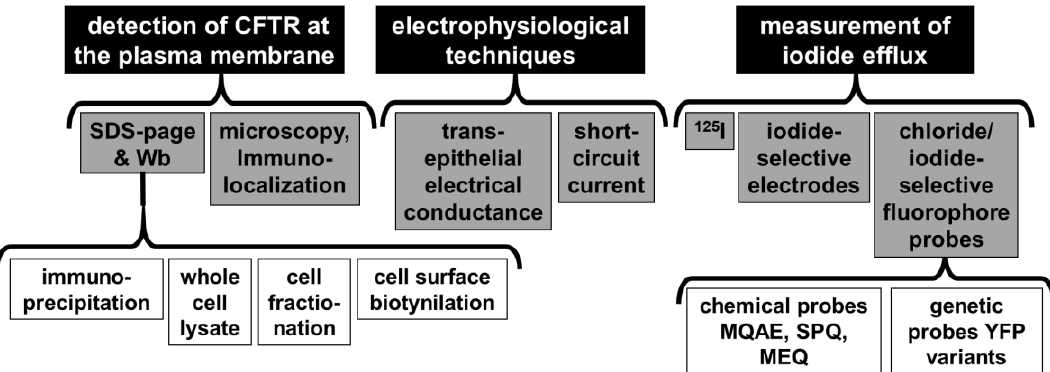
Figure 7 . CFTR functional assays. The main cell-based assays to measure CFTR activity and F508del- CFTR rescue by drugs are reported. MQAE: ( N -(ethoxycarbonylmethyl)-6-methoxyquinolinium bromide); SPQ: 6-methoxy- N -(sulfopropyl)quinolinium. MEQ: 6-methoxy- N -ethylquinolinium iodide.